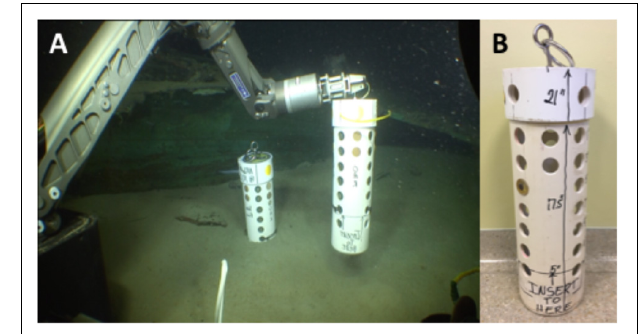
FIGURE 2 | (A) Deployment of BMPs at the bow of Anona using the Orion 7-function manipulator arm of the ROV Global Explorer . (B) Biofilm monitoring platform (BMP) used to hold carbon steel disks (CSDs) deployed at each shipwreck